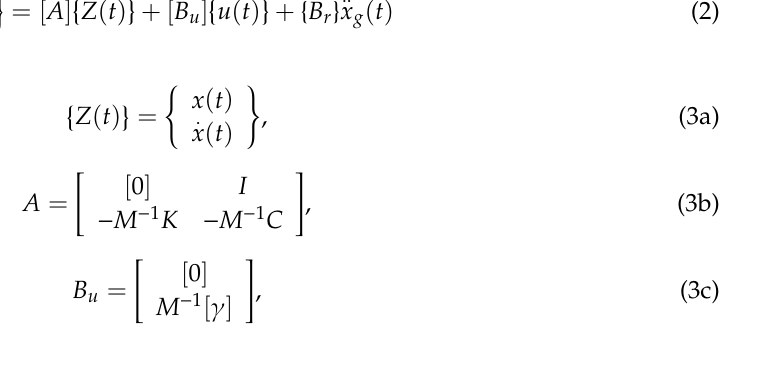
Figure 4. The configuration of the adjacent buildings used in this study.